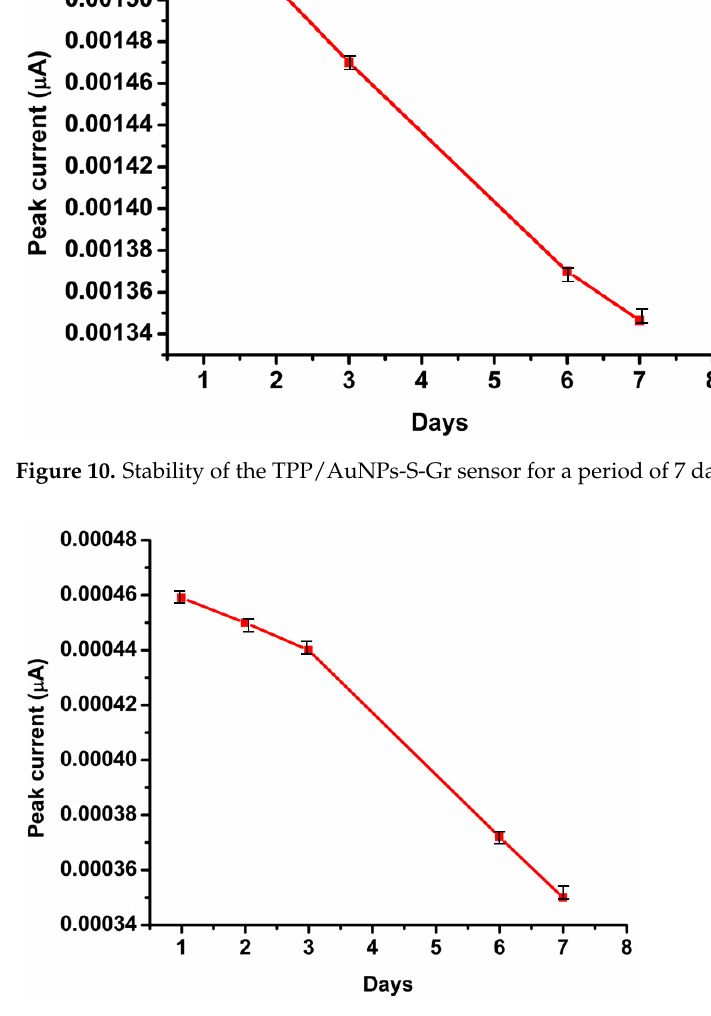
Table 4. Comparison between performances of chromatographic methods and the proposed elec- trochemical method.